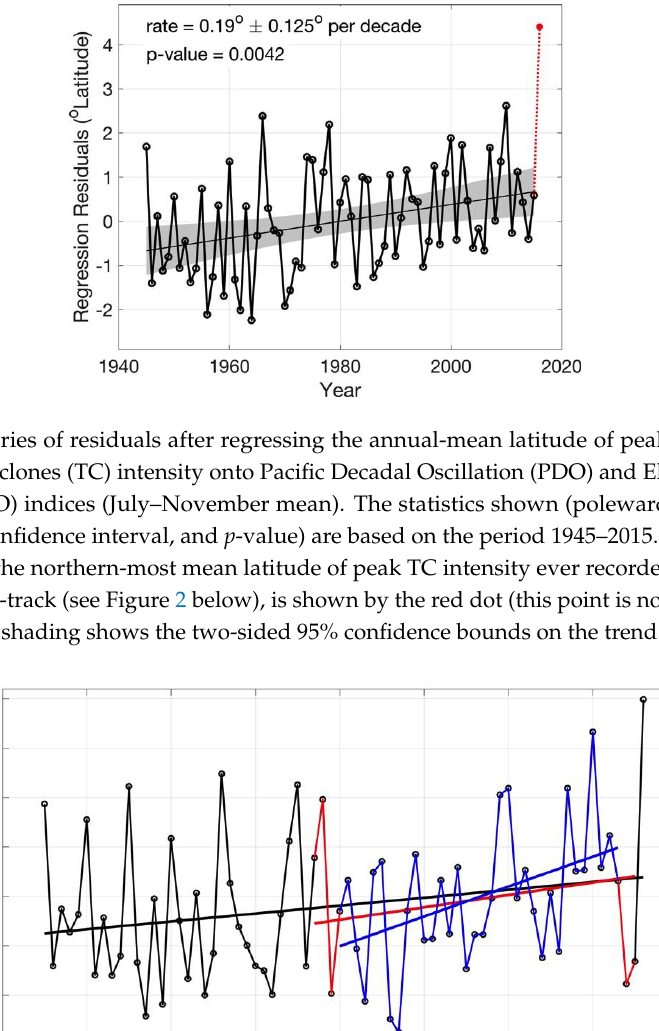
Figure 2. The effect of adding the years 1977–1979 and 2014–2015 (red) to the western North Pacific time series of KEC, which spans the period 1980–2013 (blue), in the context of the longer time series (black). The longer-term (1945–2016) trend is 0.16° decade –1 ( p -value = 0.05). The trend of KEC is 0.61° decade –1 ( p -value = 0.007). The trend in the period used by Tennille and Ellis (TE) is 0.25° decade –1 ( p -value = 0.20). The time series of KEC tends to exaggerate the migration rate, while the time series of TE is disproportionately affected by the end points.